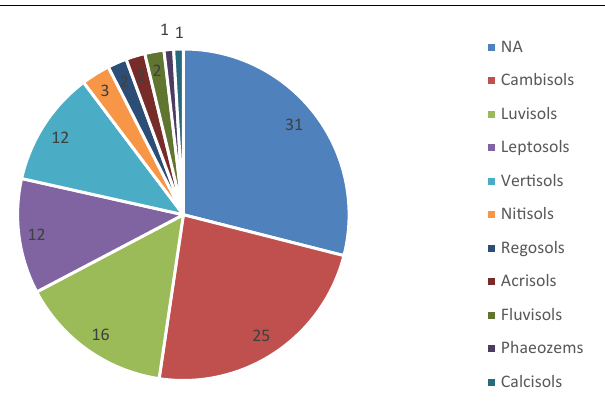
FIGURE 3 | Major soil types, defined by World Reference Base Reference Soil Groups, of the study areas covered by the studies.